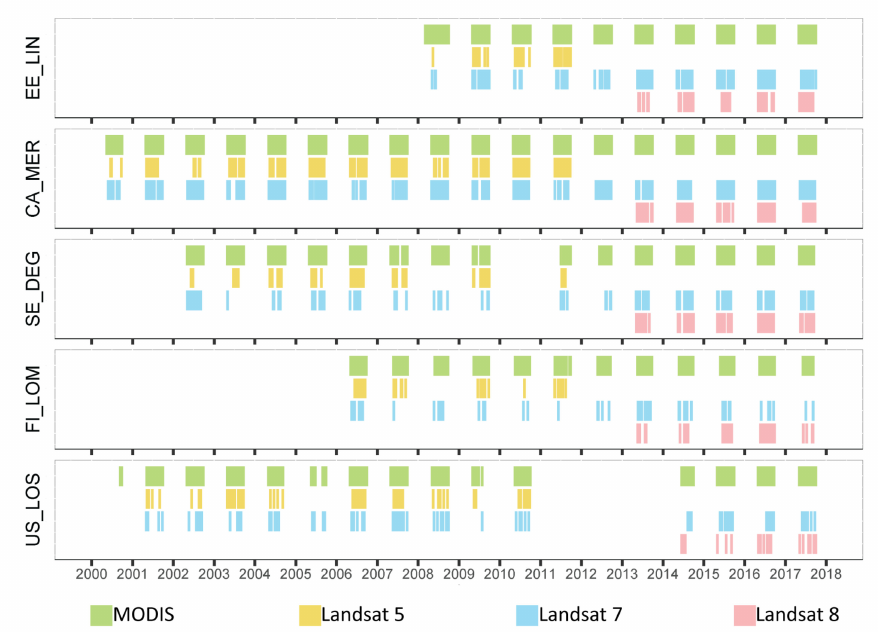
Figure 4. Temporal distribution of remotely sensed MODIS and Landsat images. The abbreviations of peatlands are given in Table